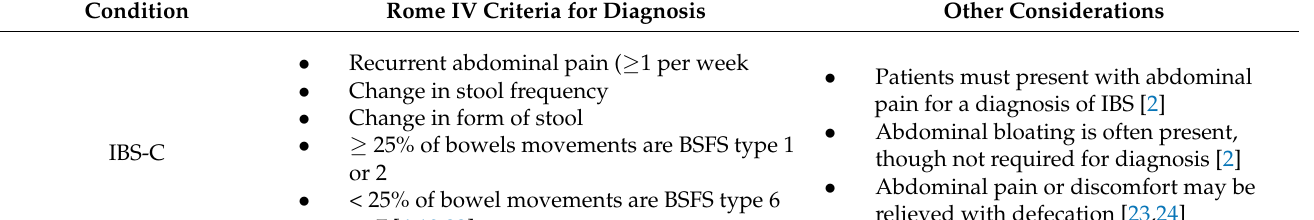
Table 1. Comparison between symptoms of IBS-C and CIC. Rome IV Criteria for Diagnosis Other